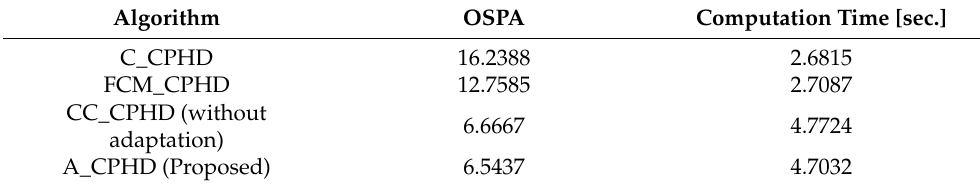
Table 1. The performance of tracking (case